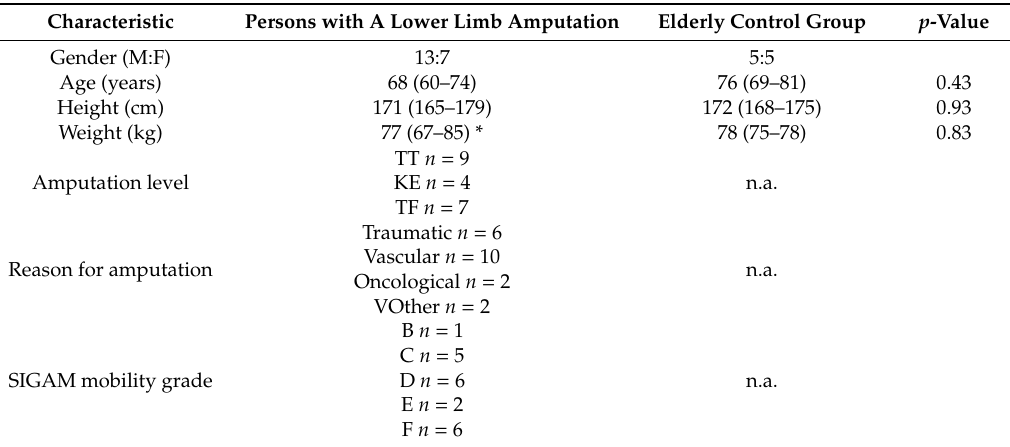
Table 1. Characteristics of persons with a lower limb amputation and elderly controls, median (interquartile